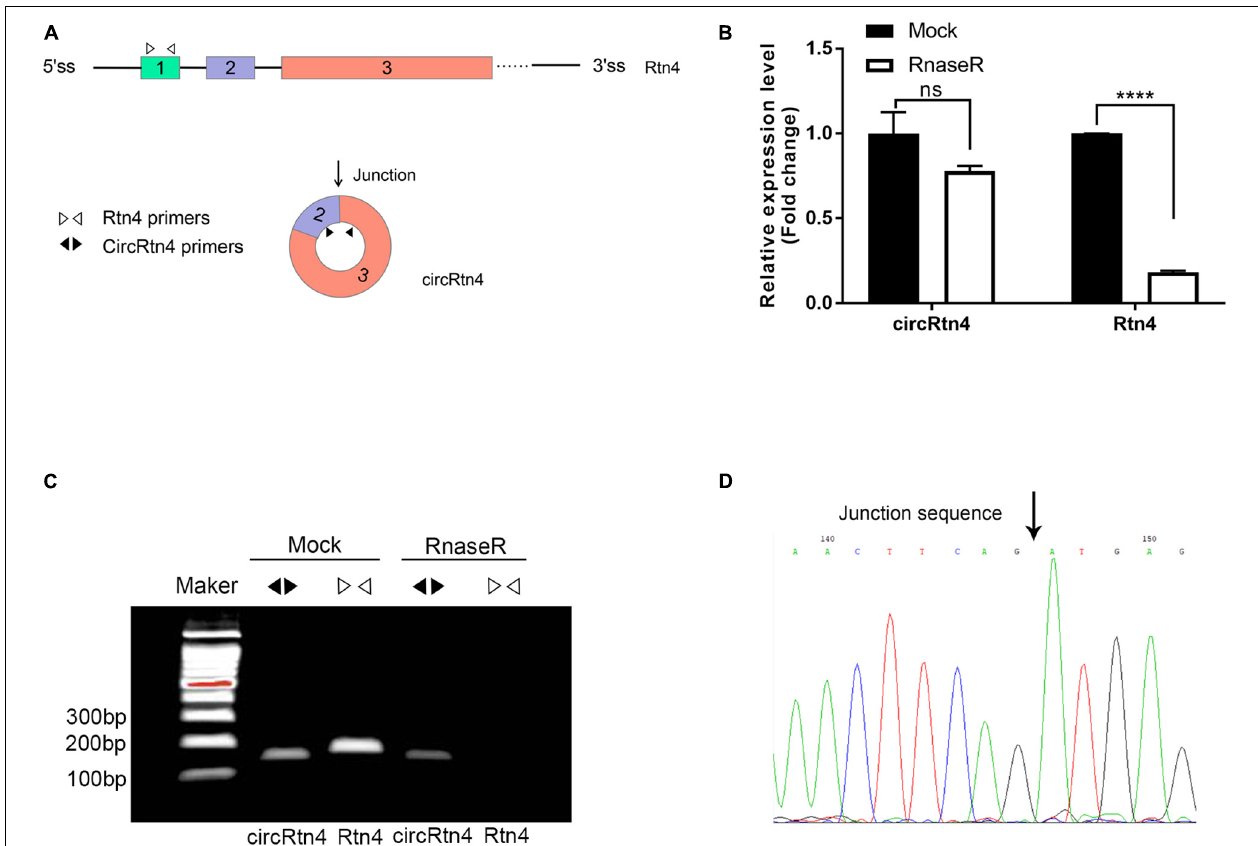
FIGURE 1 | CircRtn4 characterization and structure identification. (A) Schematic diagram of circRtn4 primers and Rtn4 primers. (B) qRT-PCR was performed to measure the expression levels of circRtn4 and linear-Rtn4 mRNA treated with or without RNase R. The results were shown as the mean ± SD (**** p < 0.0001, n = 3). (C) The existence of circRtn4 in N2a cells was confirmed by RT-PCR. (D) The head-to-tail splicing sites of circRtn4 was validated by Sanger sequencing.